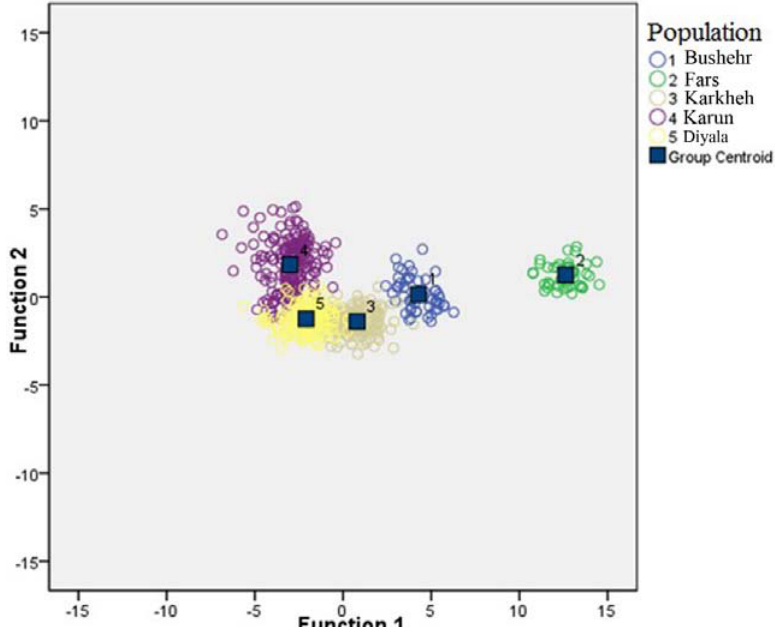
F IGURE 5. Coordinate plot of A. mossulensis from the five basins of Iran according to the first two discriminant functions from morphometric data analysis (1: Bushehr, 2: Fars, 3: Karkheh, 4: Karun, 5: